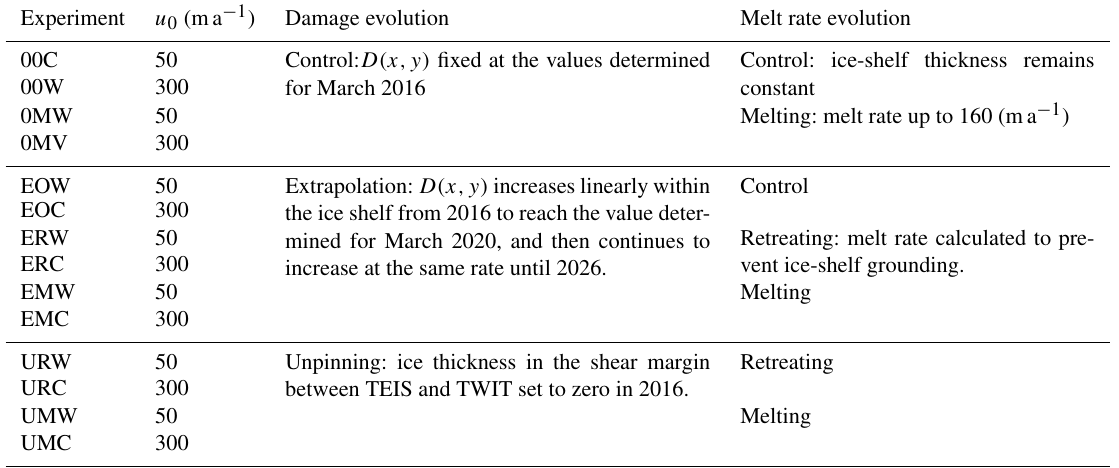
Table 2. BISICLES